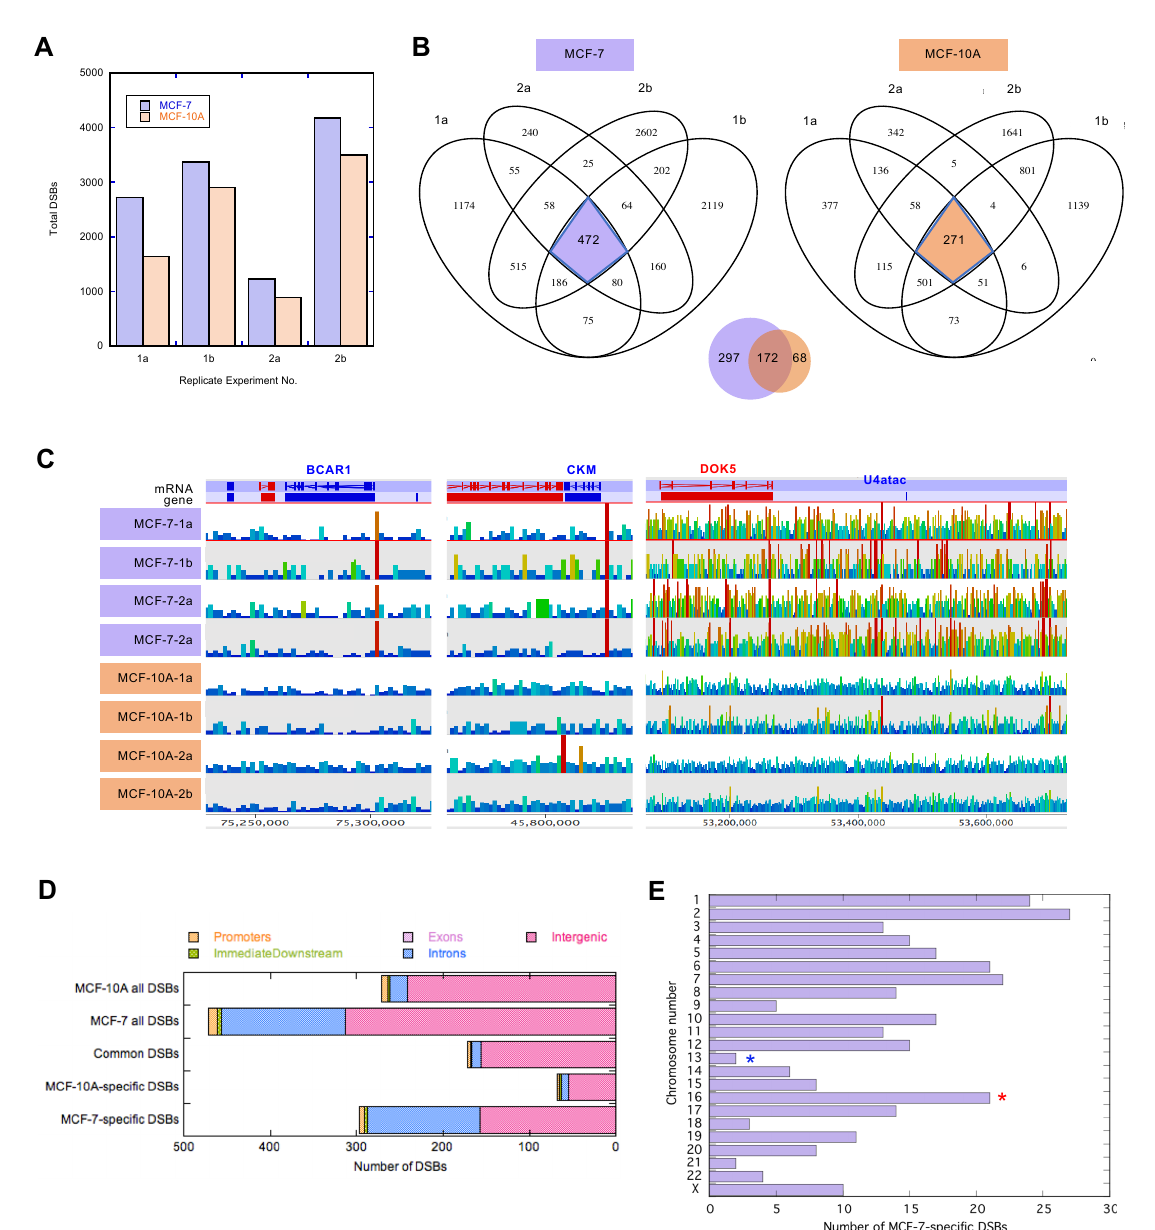
Figure 2. Break-seq analysis identifies cancer-specific chromosome breakage sites in the MCF-7 cell line. ( A ) Number of DSBs identified in each replicate experiment for both MCF-7 and MCF-10A. ( B ) Venn diagrams of consensus DSBs found in all four replicate experiments for MCF-7 and MCF- 10A. ( C ) Examples of cancer-specific consensus DSBs in MCF-7 cells and not in MCF-10A cells. The genes proximal to the chromosome breaks are BCAR1, CKM, and DOK5, located on chromosome 16q, 19q, and 20q, respectively. ( D ) Distribution of DSBs overlapping genomic features in each of the five categories as indicated. ( E ) Distribution of DSBs per chromosome. Those chromosomes with the highest and lowest number of DSBs per Mb of DNA are marked by red and blue asterisks,